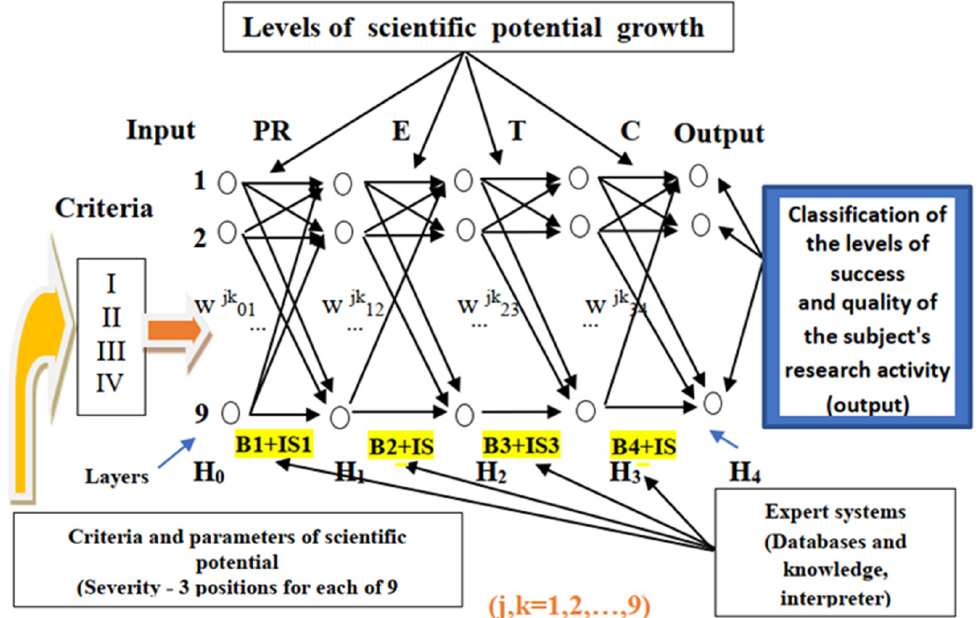
Figure 1. Dynamics of parameters and variation of levels of success and quality of students’ research activities in the layers of a hybrid neural network.